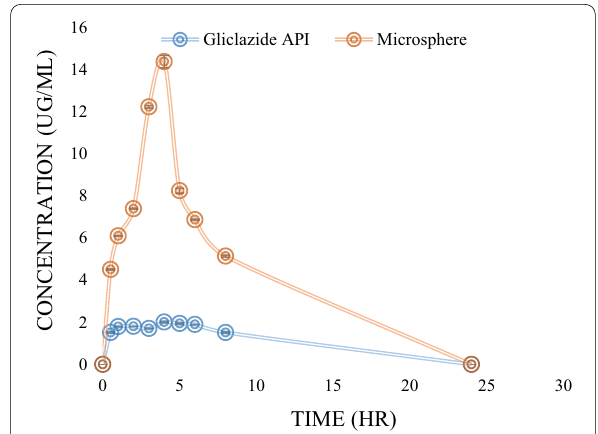
Fig. 6 Pharmacokinetic study of GLZ pure drug and GLZ microsphere